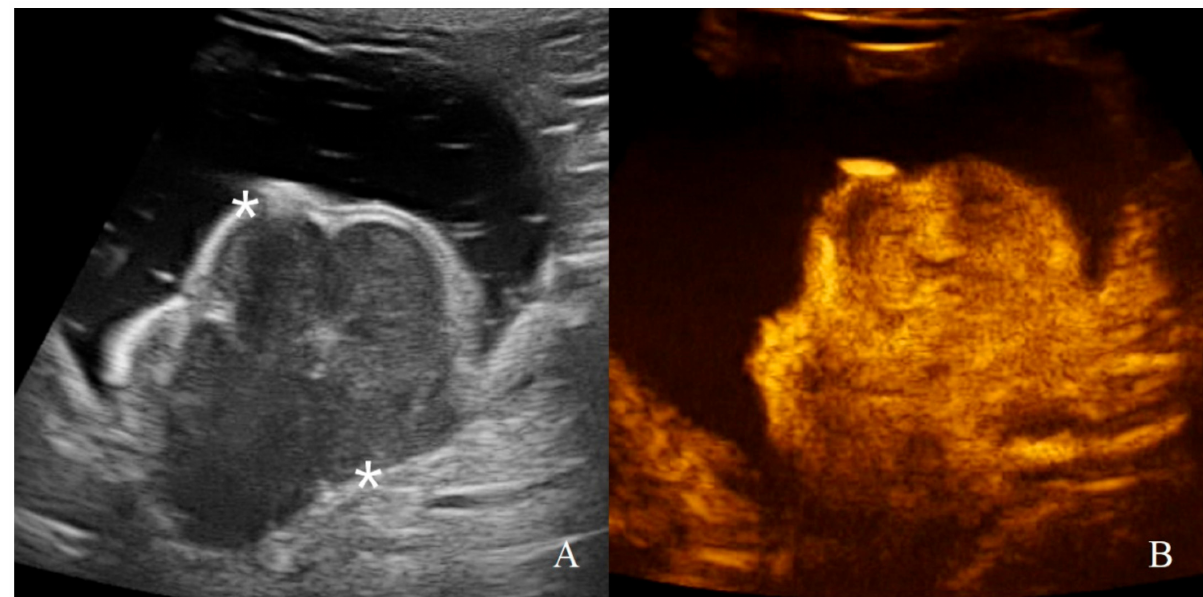
Figure 10. Gastric leiomyosarcoma in a dog: ( A ) B-mode image of a focal hyperechoic wall mass protruding into the gastric lumen (19.3 mm between asterisks) with no layers definition; ( B ) CEUS examination of the same dog during the peak enhancement of the time-intensity curve.